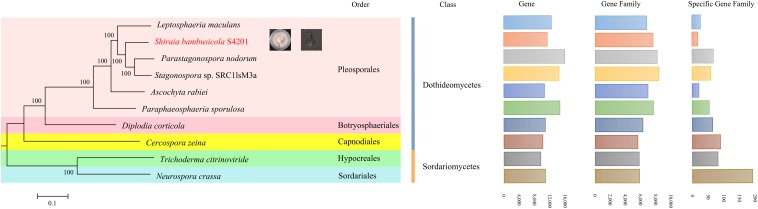
A maximum likelihood phylogenetic tree was inferred based on the highly conserved single copy orthologs of ten fungal genomes. The numbers on the branch points of the phylogenetic tree represent the bootstrap values (1000 replicates). Scale lengths represent the genetic distance. The 10 fungi are marked with different colors. The statistics for gene numbers, family numbers, and unique families in the 10 fungal species are shown.